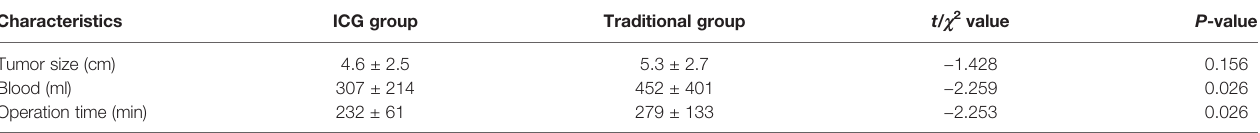
TABLE 3 | Intraoperative index between the ICG-guided and traditional groups.